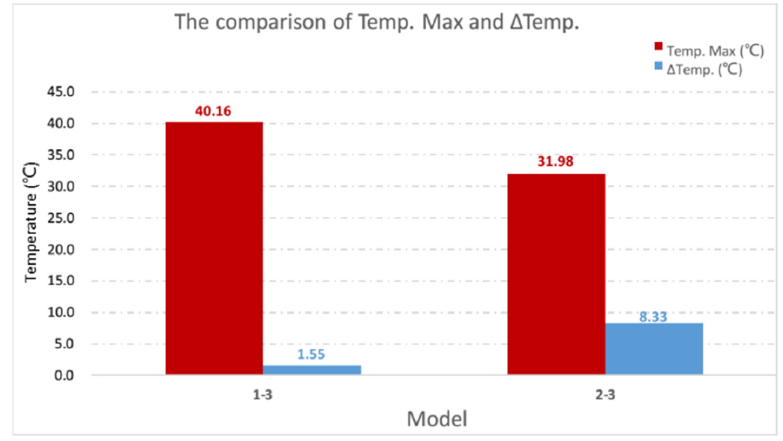
Figure 15. The comparison of max temperature and the temperature difference between two cooling systems.